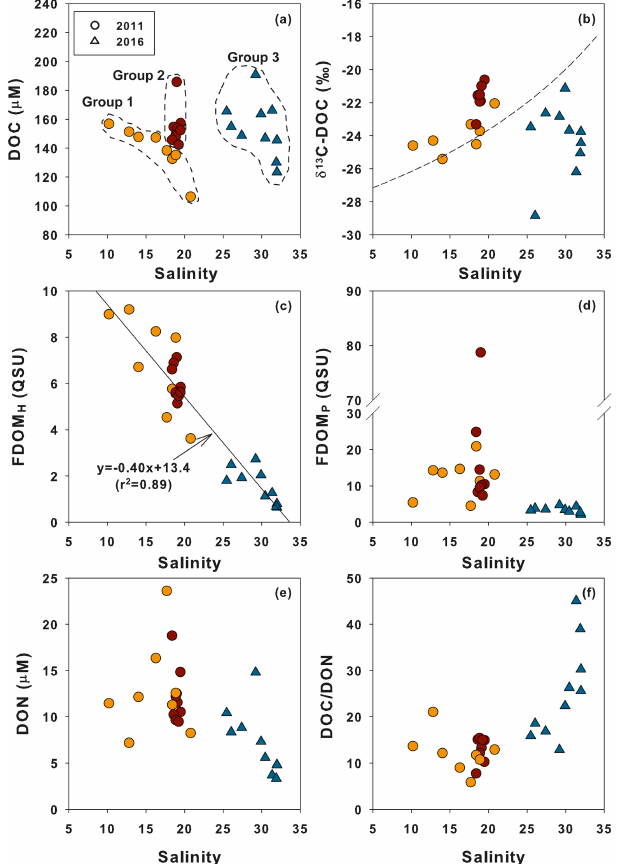
Figure 4. Relationships between salinity and (a) DOC, (b) δ 13 C- DOC, (c) FDOM H , (d) FDOM P , (e) DON, and (f) DOC / DON ra- tio values. The DOC concentrations are divided into three groups based on probable different sources (in the dashed circles). The dashed line (b) represents the binary conservative mixing line for δ 13 C-DOC between the terrestrial end-member and the marine end- member. The solid line (c) represents a linear regression fit of the data.